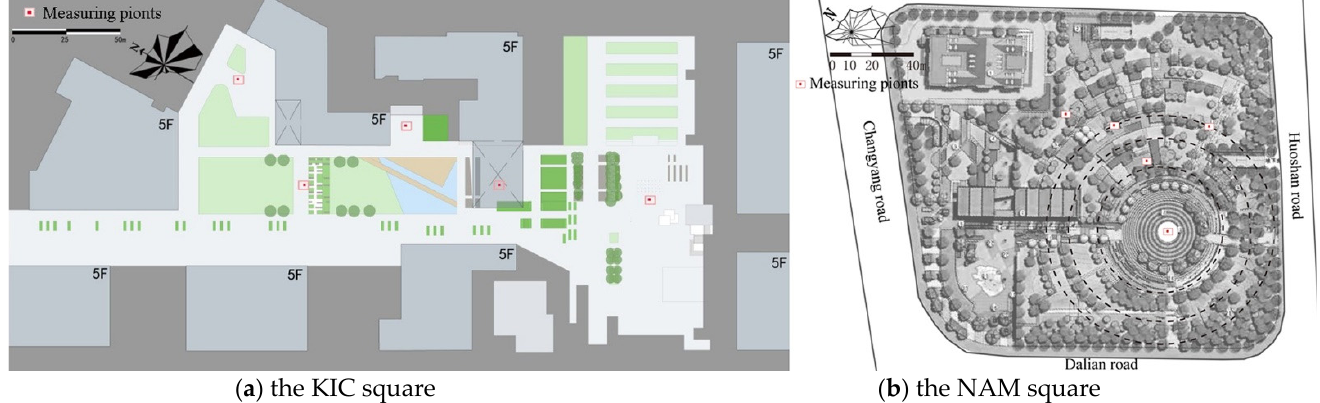
Figure 1. The measuring points of the two squares.